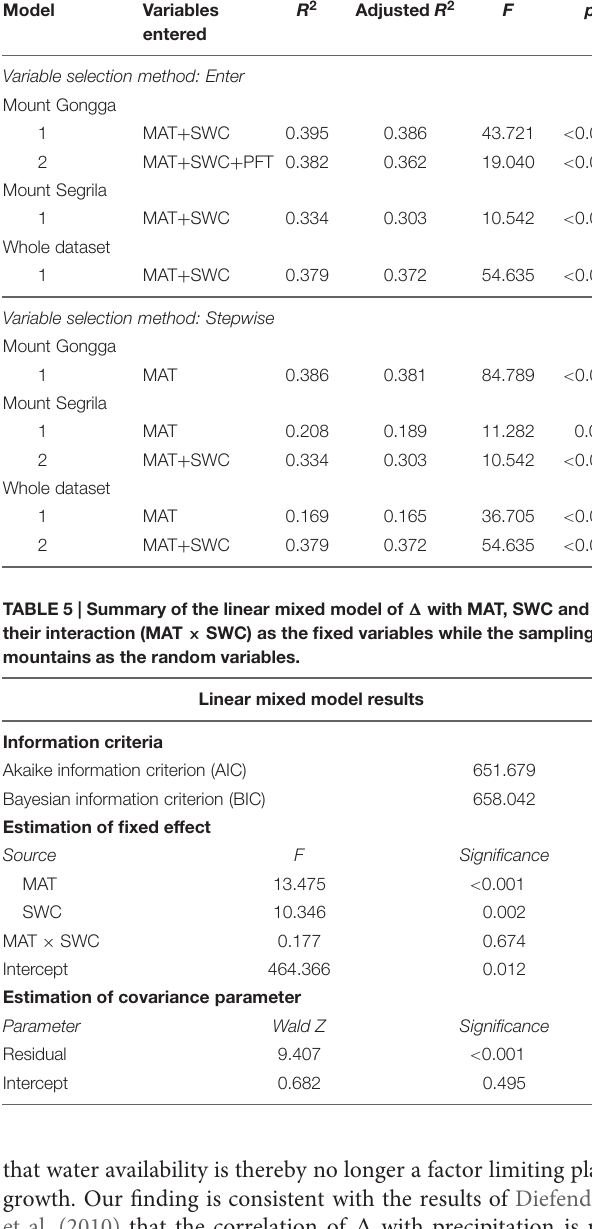
TABLE 4 | Multiple linear regression of plant (cid:2) against MAT, SWC, and PFT. Model